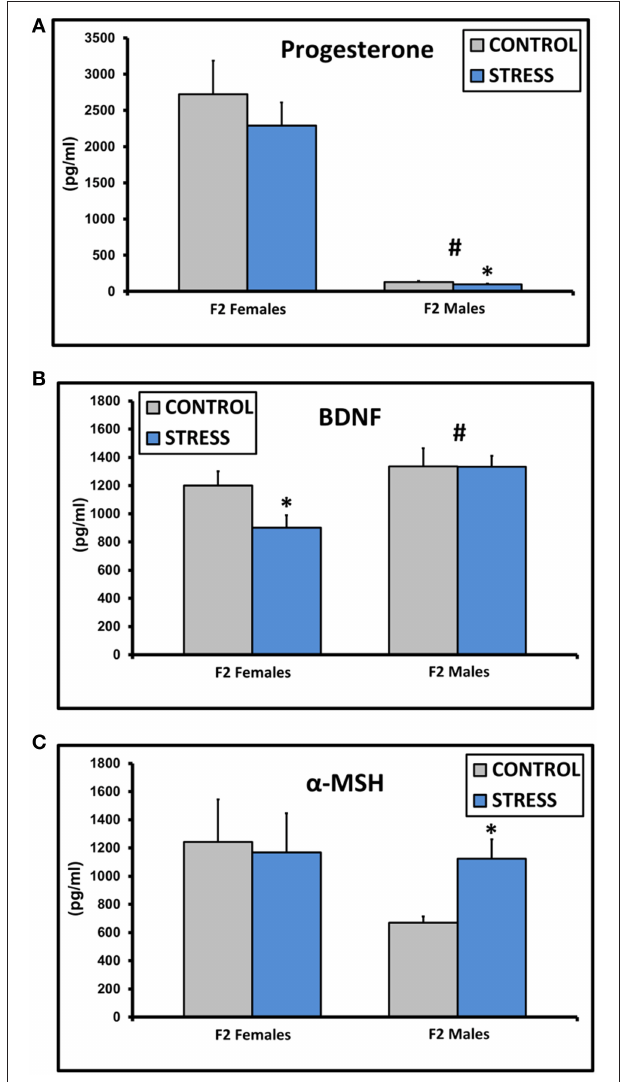
FIGURE 3 | Mean ± SEM basal plasma levels of progesterone (A), BDNF (B), and α -MSH (C) in the adult F2 male and female offspring of control dams and dams exposed to chronic social stress during lactation. * Denotes significant effect of CSS treatment, # denotes significant effect of sex ( p < 0.05